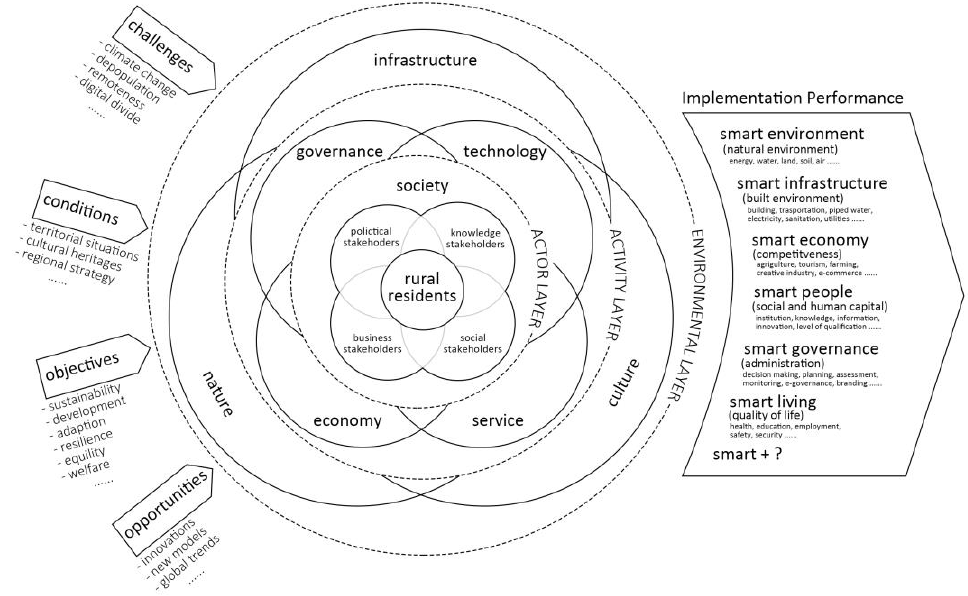
Figure 10. A dynamic conceptual model of a smart village. Proposed by the authors based on Giffinger and Gudrun, 2010 [86]; Fernandez-Anez et al., 2018 [112]; Mishbah et al., 2018 [36]; and Zhang and Zhang, 2020 [85].